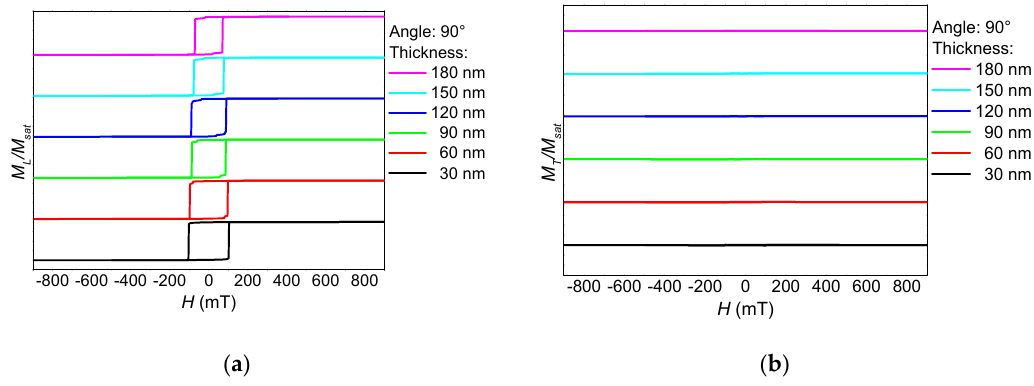
Figure 8. Thickness dependence of ( a ) the longitudinal and ( b ) the transverse hysteresis loops, simulated for sample NF2 under an angle of 90°.